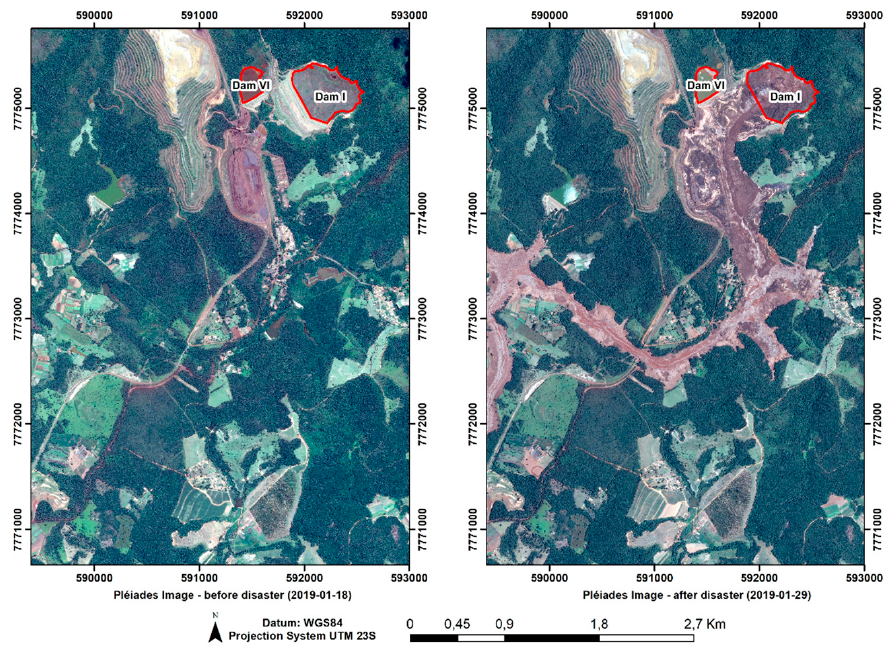
Figure 2. Pleiades satellite images taken just before and after the tragedy, showing the water from Dam-VI, the tailings from Dam-I, and the Corrégo do Feijão